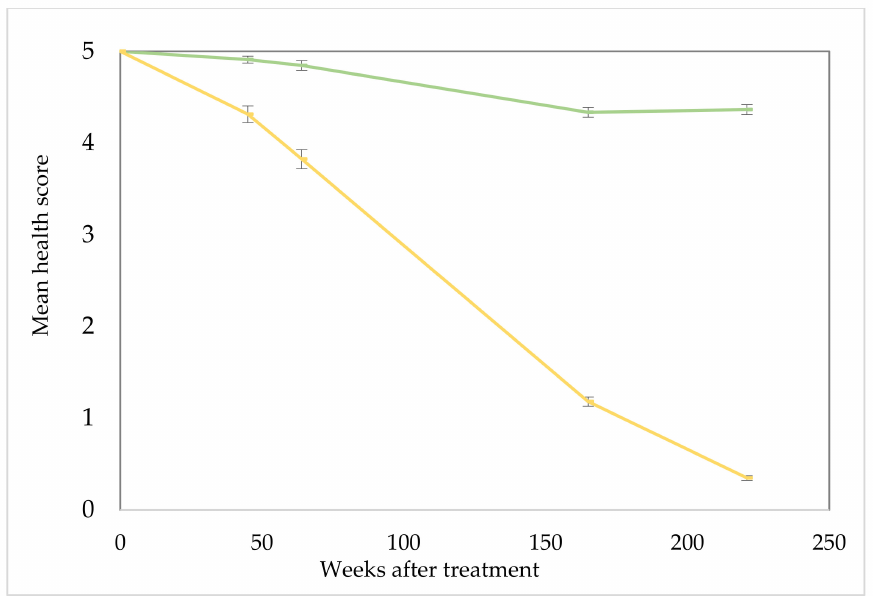
Figure 2. North parkinsonia infestation overall health score over trial duration (0, 45, 64, 165 and 221 WAT). Treated plants (gold), untreated control plants (green). Health score ratings, 5 = highest health score (>95% alive); 4 (71–95% alive); 3 (51–70% alive); 2 (31–50% alive); 1 (<30% alive); 0 (tree assessed as dead). Error bars represent ± standard error of means.